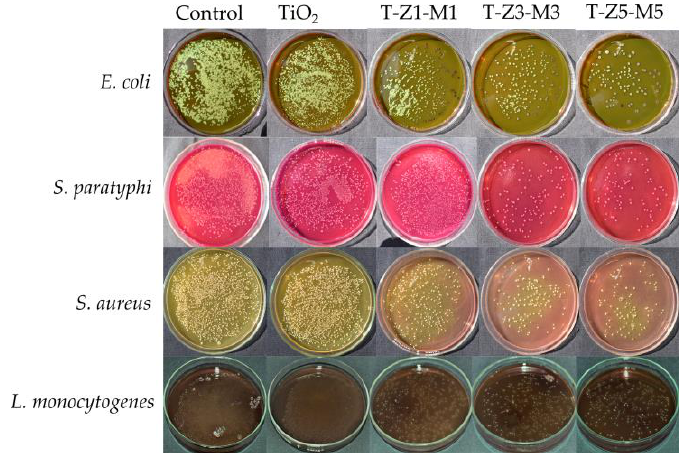
Figure 5. Viable cells of different pathogenic bacteria under TiO 2 and mixed oxide nanoparticles. T –